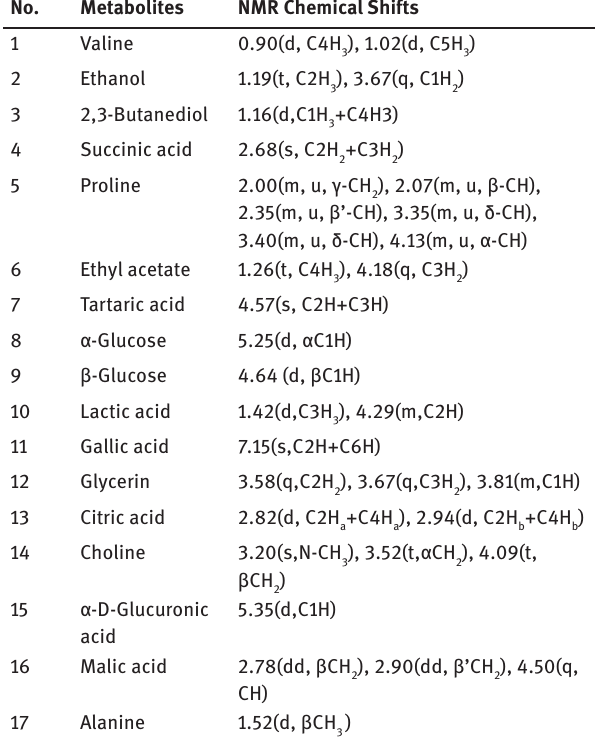
Table 1 1 H NMR assignment of metabolites in Cabernet Sauvignon and Shiraz dry red wines.